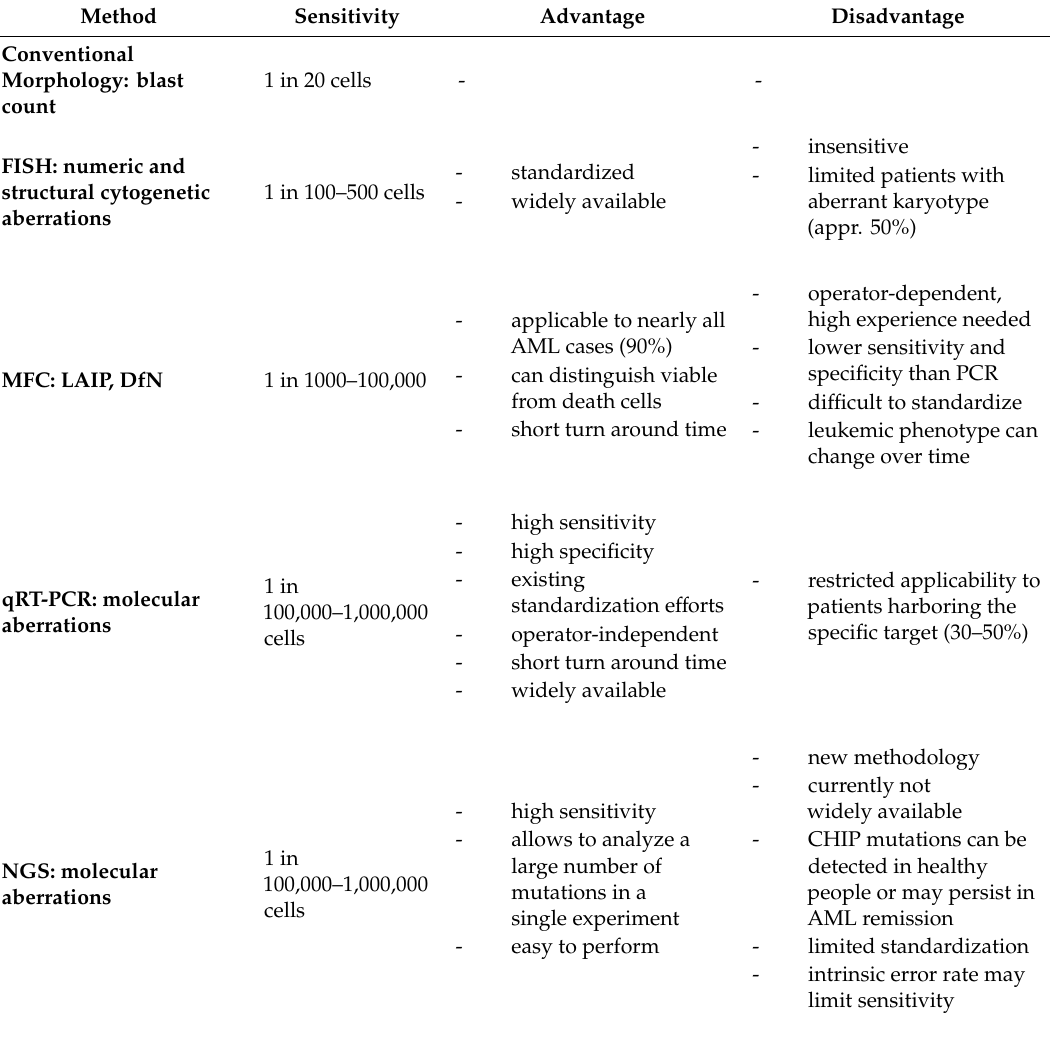
Table 2. Comparison of di ff erent approaches to analyze measurable residual disease